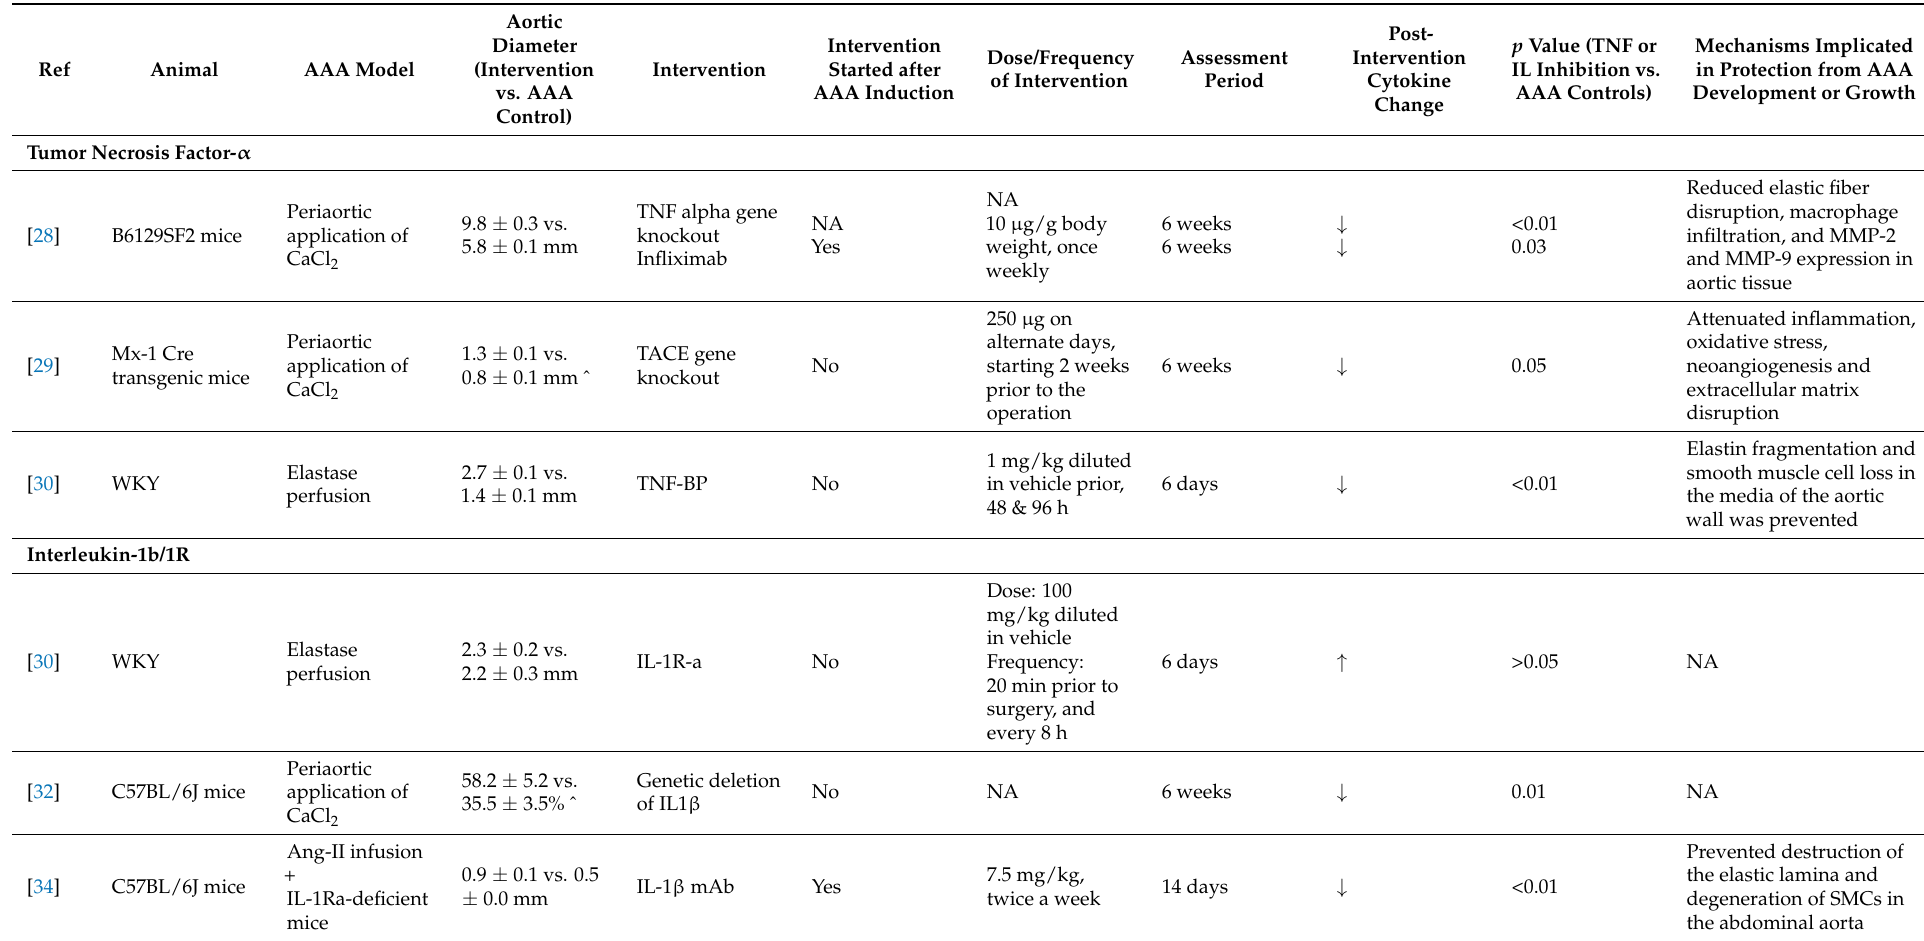
Table 2. Examples of studies investigating the effect of inhibiting tumor necrosis factor or interleukins in AAA animal